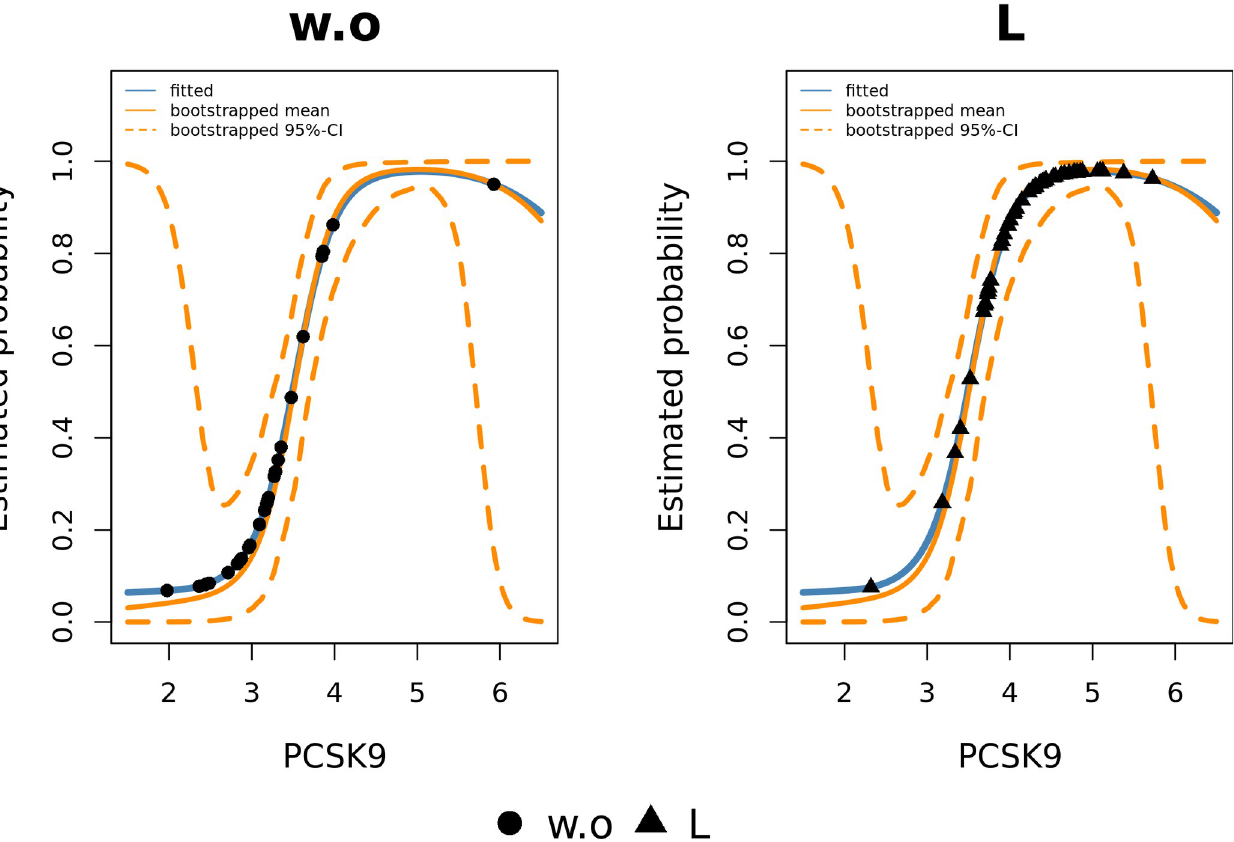
Fig 8. The estimated probability of being classified as ‘L’ in scenario w.o-L using PCSK9 with gamboost. Blue and orange solid lines represent the prediction results of the fitted gamboost and the bootstrapped mean prediction results, respectively. The dotted lines describe the bootstrapped 95% confidence interval. The left plot shows the observation of status w.o and the right plot the observation of status L.